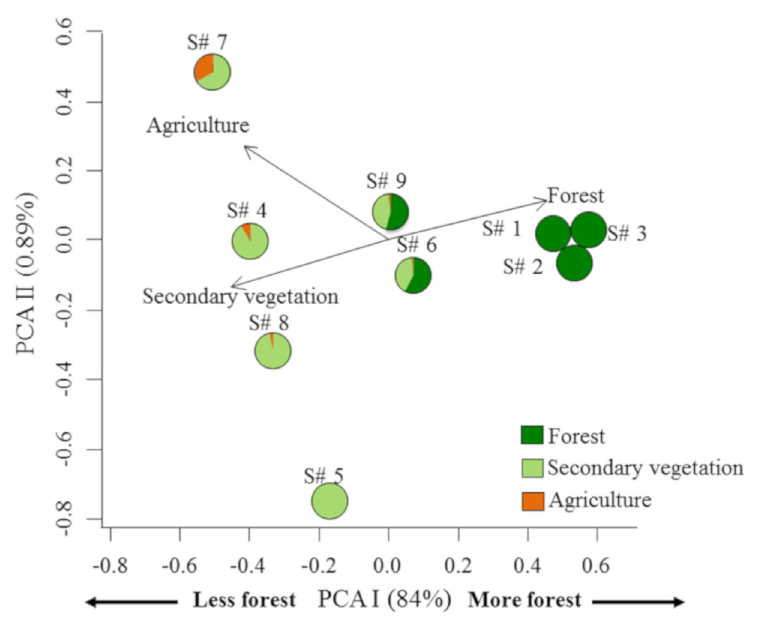
FIGURE 2 | Principal component analysis performed with the percentages of land use in 60 m riparian buffers in the catchment of nine streams located in the Tanguro Farm, Municipality of Querência, state of Mato GrossoT. Sites 1, 2, and 3 overlapped, and were rearranged for better visualization. Sgrid: Site.